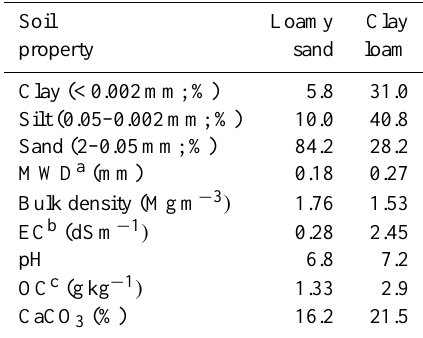
Table 1. Some physical and chemical properties of the soils with different